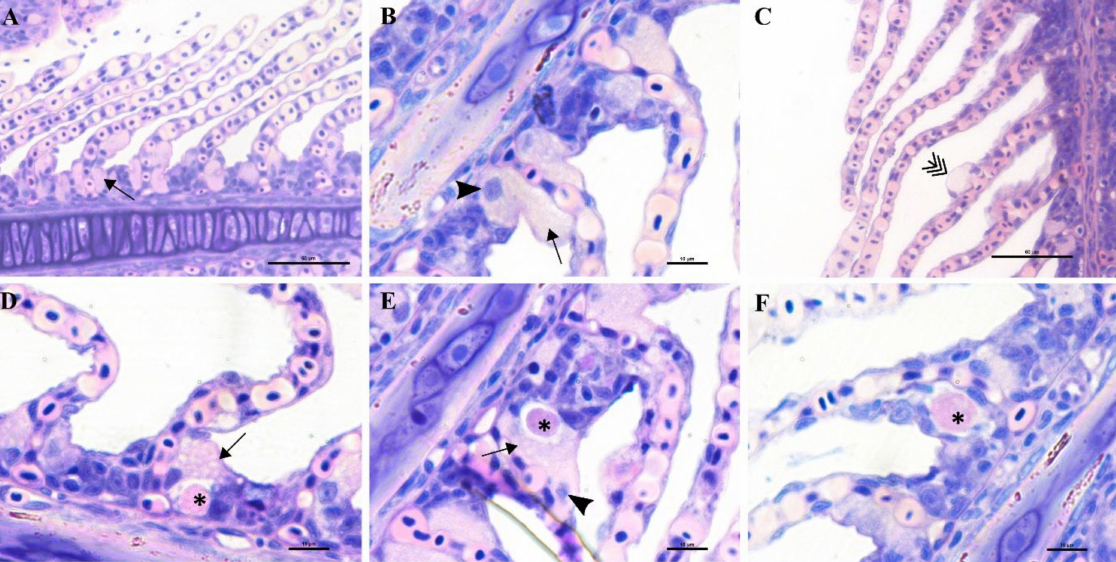
Figure 5. Histological sections of greater amberjack gills (cohort 2018) one month after transfer to sea cages (polychrome stain). ( A , B ) Normal gills showing ionocytes at the base of the lamellae (arrow); the basophilic nucleus of the ionocyte is shown by the arrowhead. ( C ) Enlarged cell along the lamella (multiple arrow). ( D – F ) Pictures obtained from samples positive for Ca . Ichthyocystis and negative for chlamydial agents. ( D , E ) Pinkish inclusions (asterisk) in a peripherical area of the cytoplasm of ionocytes at the base of the lamellae; the basophilic nucleus of the ionocyte is shown with the arrowhead. ( F ) Similar inclusion at the base of secondary lamellae